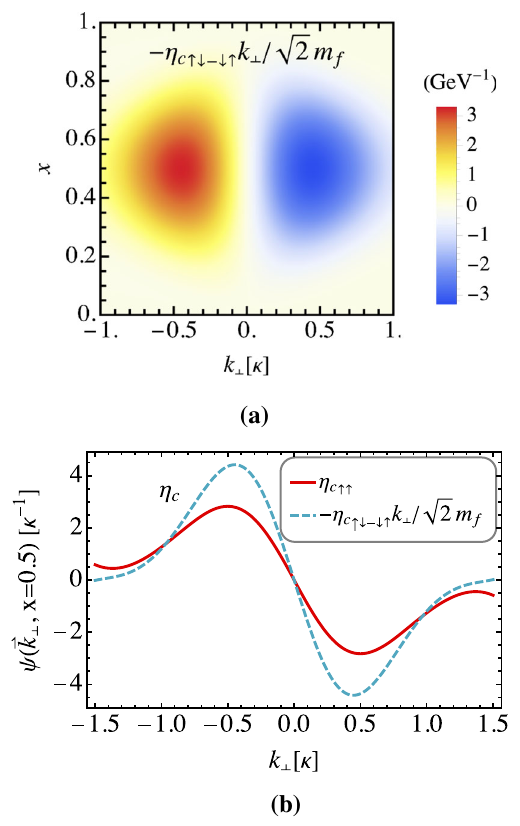
Fig. 7 Comparisonsofdifferentspincomponentsof η c .Thewavefunc- tions are defined in Eq. (50), with the basis parameter κ = 1 . 34 GeV and m f = 1 . 27 GeV. (a) The spin component ψ ↑↑ generated from ψ − by the CLFD relation in Eq. (43) [contrast with Fig. 6b]; (b) comparison of the ψ ↑↑ component in this work and CLFD generated component at x = 0 . 5